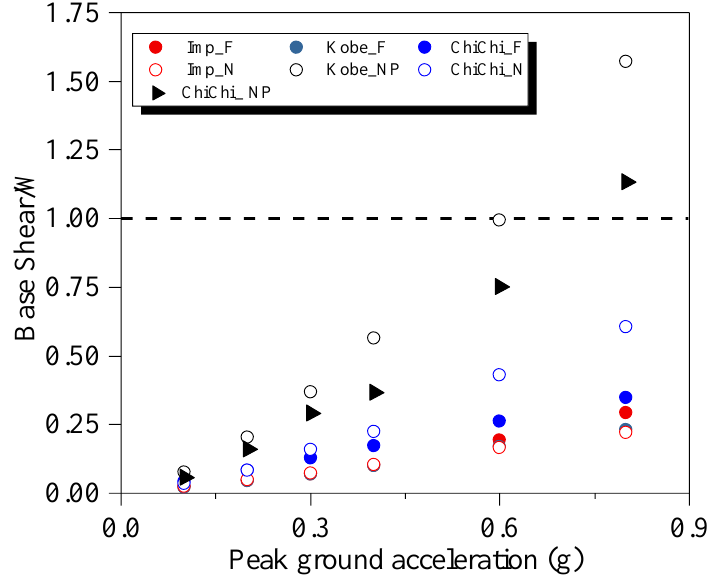
Figure 9. Base shear variation with the PGA of the ground motion inputs. The overturning moment of the superstructure induced a substantial variation of the axial load on the north or south bearings. In a few cases, tension was afforded in the LNRs. Figures 10 and 11 present the histories of axial force on the bearings for the isolated moment frame structure subjected to the Kobe_NP_0.60 g and ChiChi_NP_0.60 g, respectively. The bottom graph in the figures displays the history of the total axial forces on all four bearings. When the ground motion PGA was 0.6 g, the total axial force on all four bearings slightly varied, indicating that there was little vertical acceleration on the model. In contrast, the total axial force in the two north and south bearings experienced large variations of the order of 100%. This considerable variation in the total axial force of four bearings